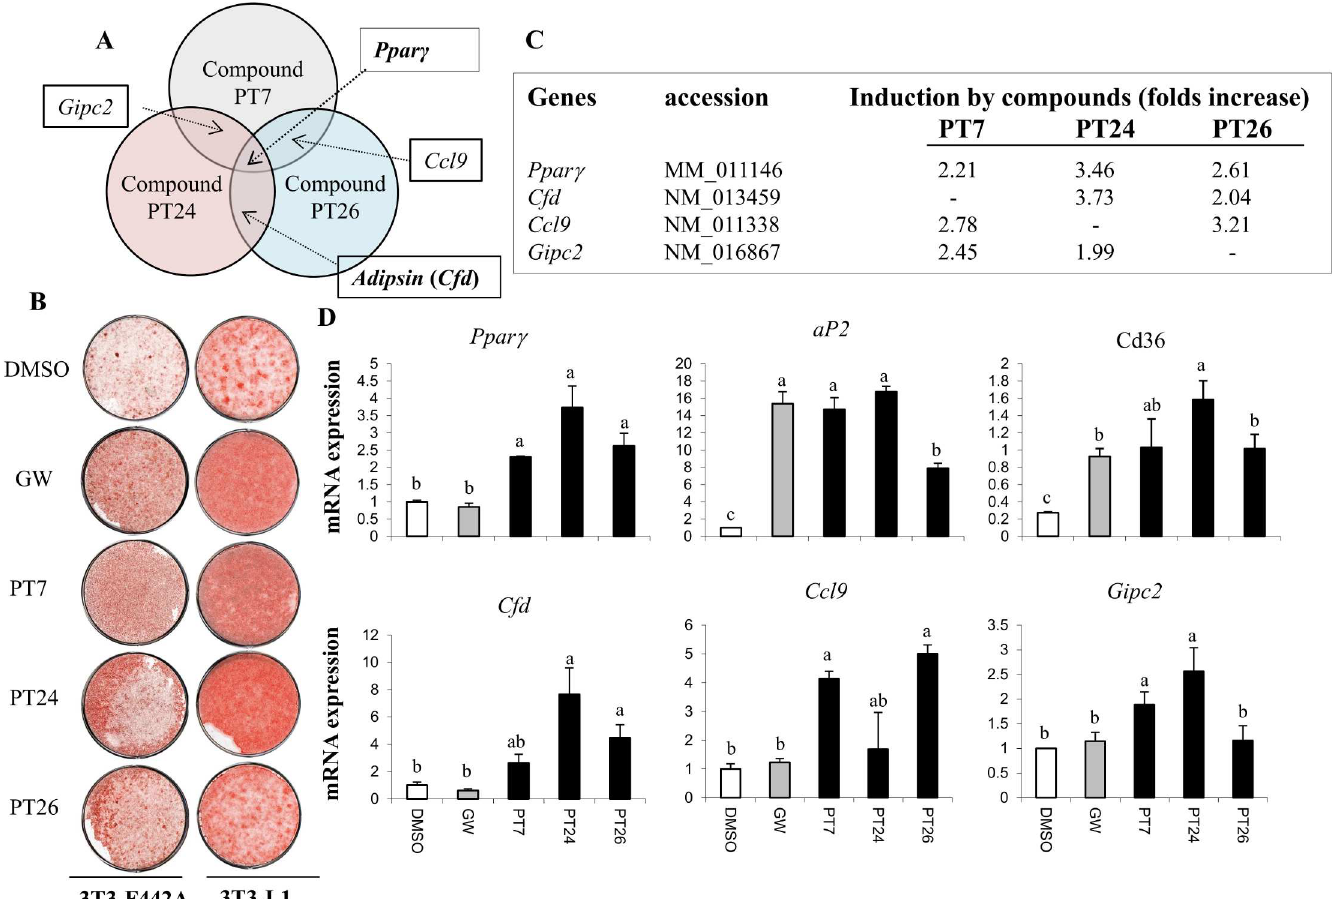
Fig 1. Inductionof Cfd by adipogenic smallmolecules. ( A ) A diagram showing the overlap genes induced by pro-adipogenic small molecules. 3T3-F442Apreadipocytes were treatedwith GW7845or compounds and the induced genes ( > 2.0folds) were identifiedby microarray analysis. Ppar γ agonist(GW7845)-induced genes ( > 2.0 folds) were excluded fromthe candidates. Ppar γ is the overlapping gene induced by threeadipogenic compounds. Gipc2 , Ccl9 ,and Cfd were induced by at least two pro-adipogenic compounds. ( B ) Pro-adipogenic effects of the selectedcompounds were verified in 3T3-F442Aand 3T3-L1cells. The confluent3T3-F442Apreadipocytes were stimulatedwith adipogenicmediumcontainingDMEM,10% FBS, insulin,and the selected compounds for 6 days. Lipid accumulation was assessed with Oil red O staining.The 3T3-L1preadipocytes were induced into adipocytesin adipogenic mediumcontaining DMEM,10% FBS, dexamethasone, IBMX,insulin,and the selected compounds. Then,the 3T3-L1cells were refreshedwith mediasupplemented with insulin and compounds every 2 days until day 6. ( C ) Fold inductionof pro-adipogenic small molecule-induced genes comparedto DMSO treatedcells is shown. ( D ) Expressionof Cfd ,Ccl9, and Gipc2 induced by the selected compounds was verified in 3T3-F442A cells. 3T3-F442Apreadipocytes were treatedwith GW7845and the selectedcompounds for 24 hours. Inductionof adipocyte markers was assessed by real timePCR. Data are presentedas means +/- s.d. and are representative of threeindependent experiments. Statistical significance differences were determinedusing one- way ANOVA and the Student-Newman-Keuls test.Different letterat each samplesare significant( p <